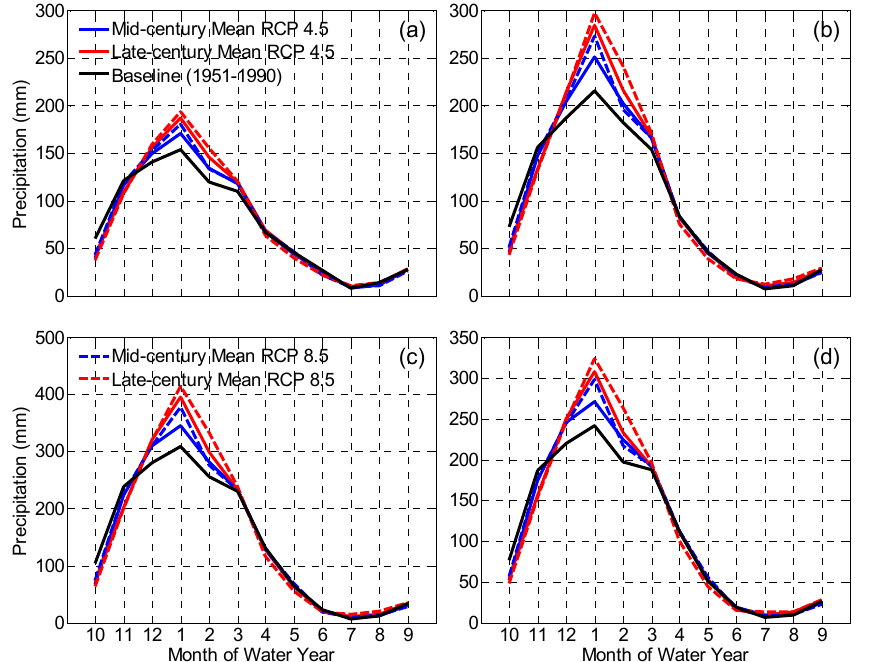
Figure A6. Monthly mean precipitation projections for ( a ) Sacramento River above Bend Bridge, ( b ) Feather River, ( c ) Yuba River, and ( d ) American River under RCP 4.5 and RCP 8.5 projections, respectively.